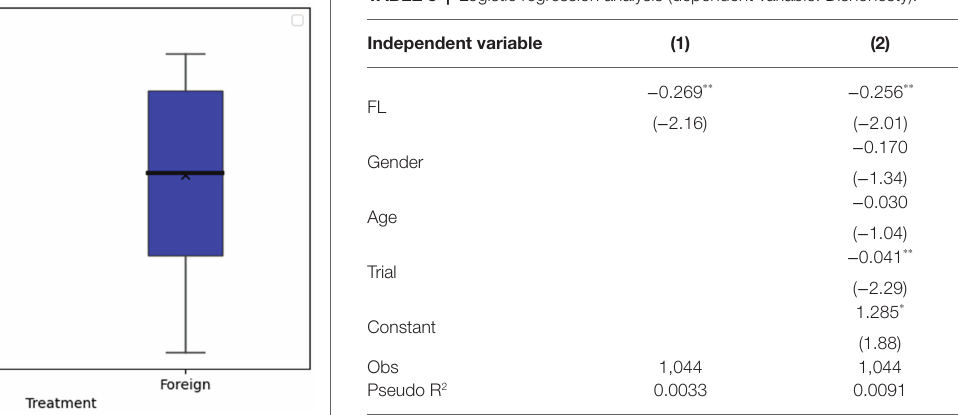
TABLE 5 | Logistic regression analysis (dependent variable: